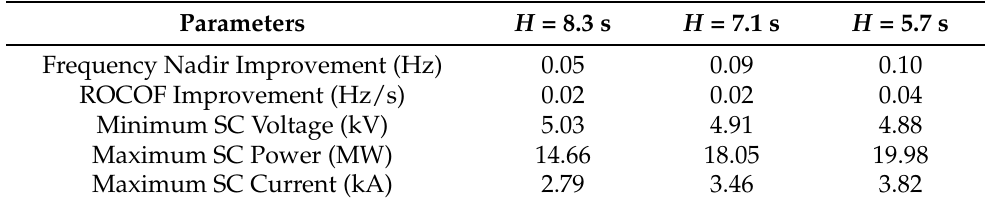
Table 1. Overview of simulation results of FFR provision from the directly connected SC in systems with different inertia